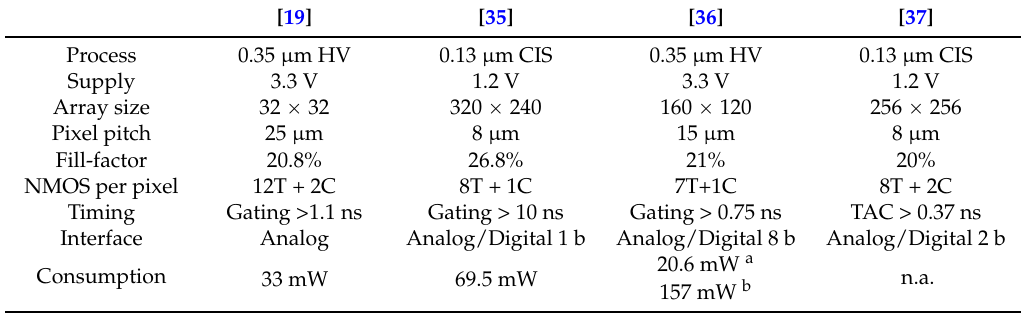
Table 1. Comparison between recent compact analog-based SPAD sensors for time-resolved